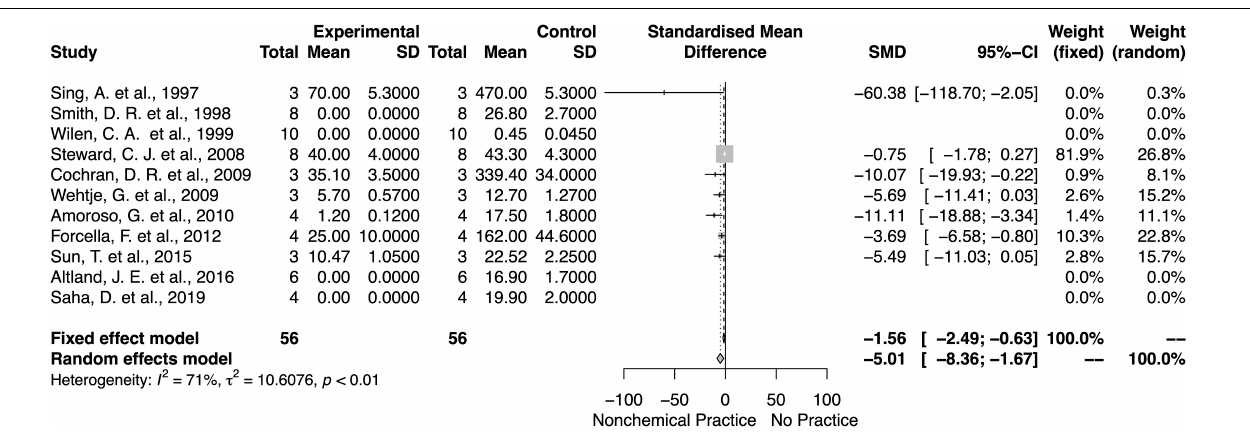
FIGURE 8 | Meta-analysis for the non-chemical weed control method on weed